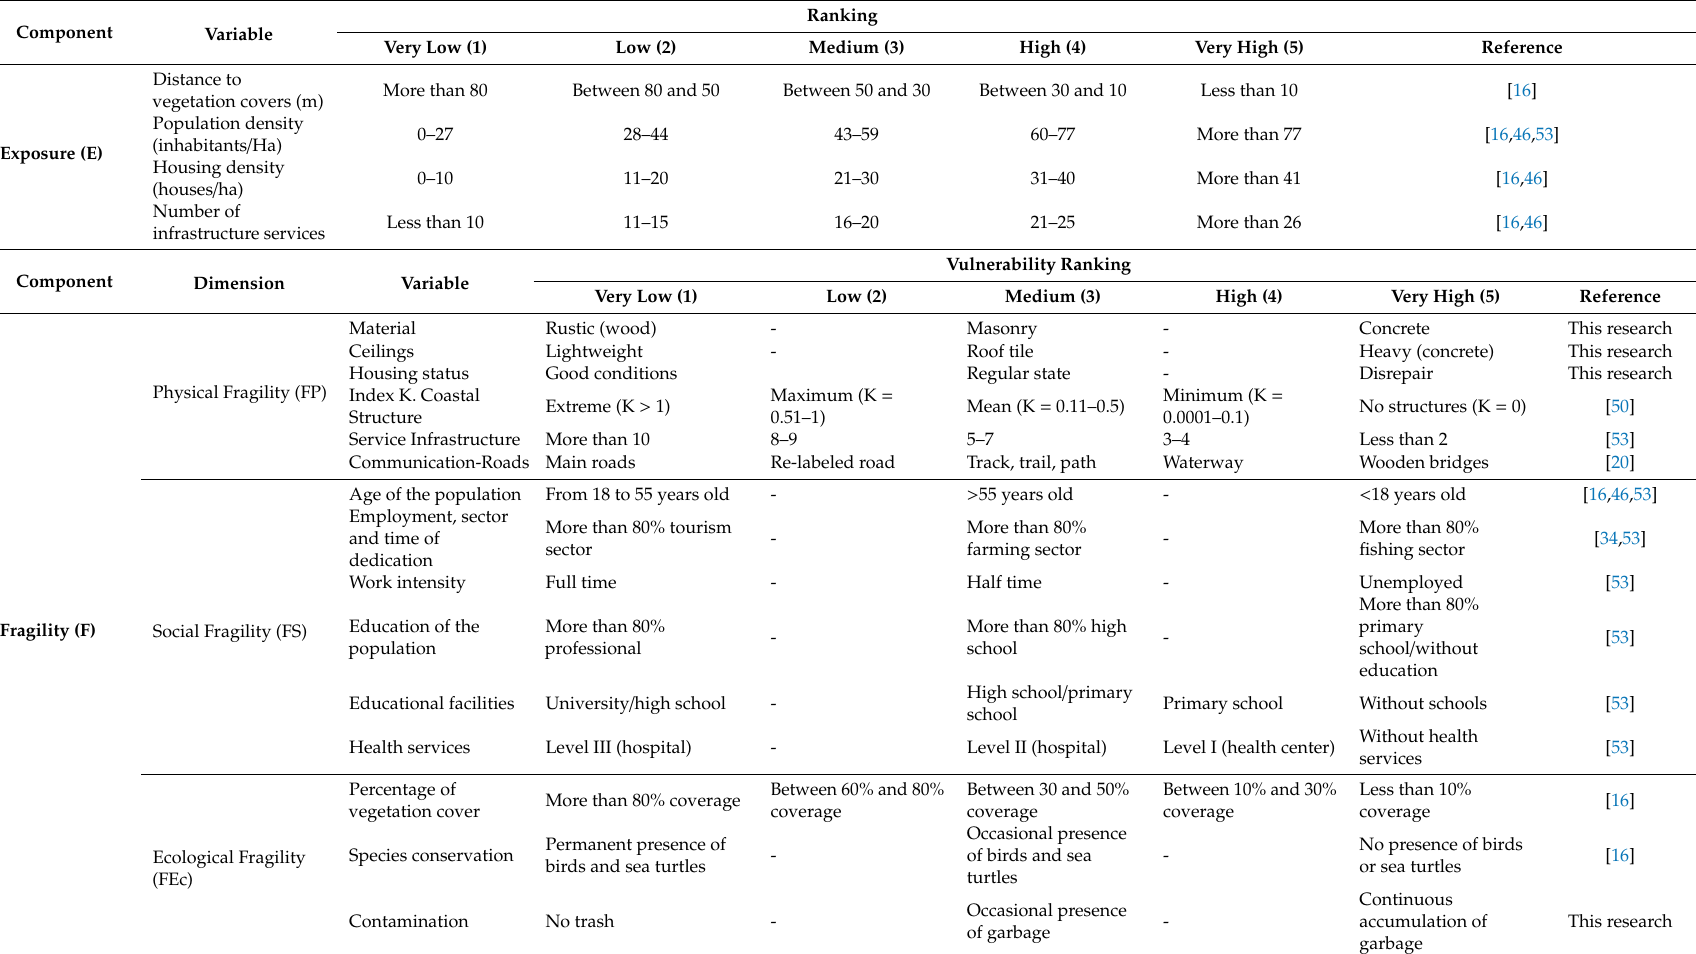
Table 2. List of variables per component considered in the vulnerability assessment and ranking